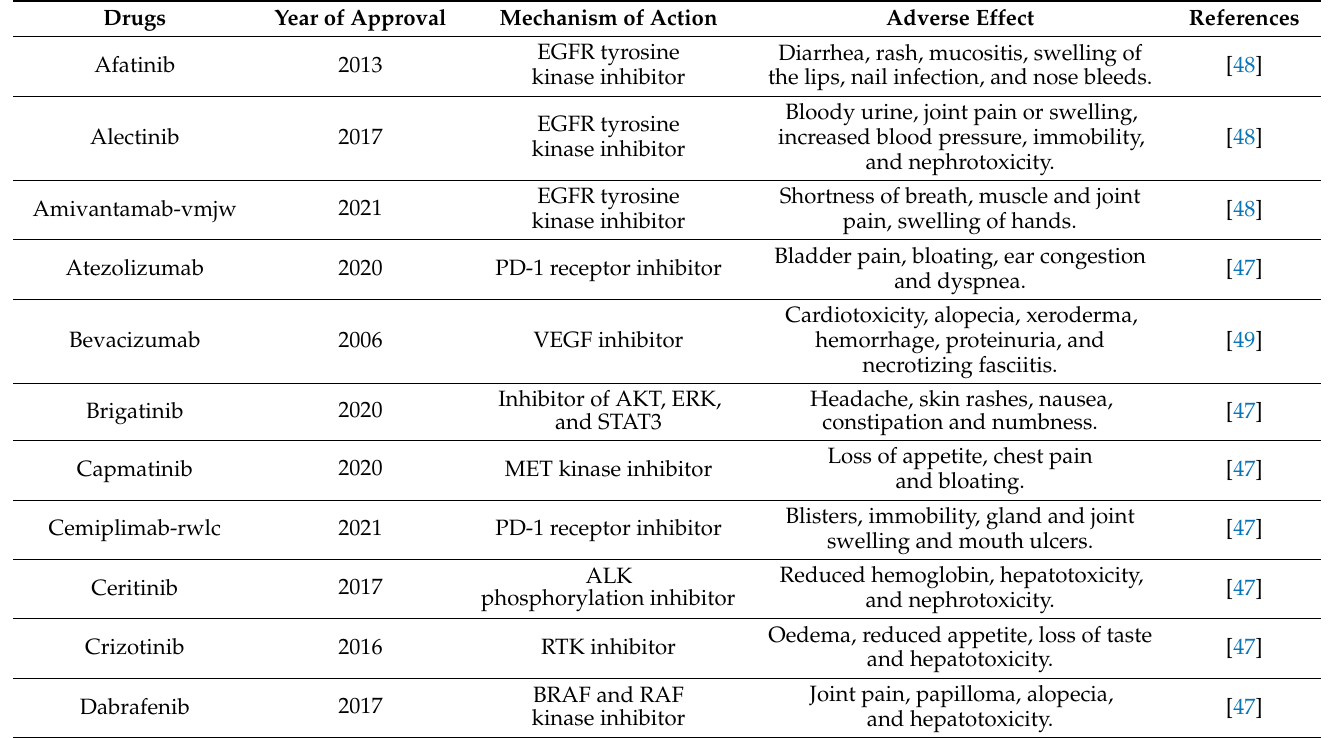
Table 1. Showing the details of FDA approved drugs and their adverse